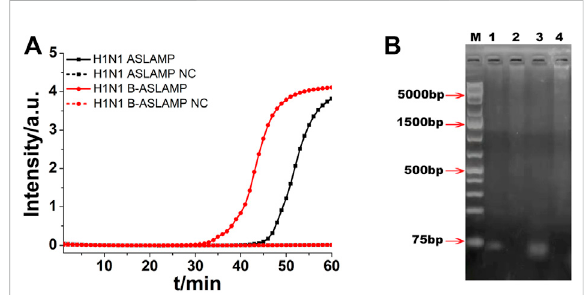
FIGURE 3 (A) ASLAMPand B-ASLAMP ampli fi cations monitored byreal- time PCR carried out at 63 ° C for 60 min. (B) Gel electrophoresis results for ASLAMP and B-ASLAMP products prior and after restriction enzyme digestion. Line M, molecular weight marker. Lane 1, H1N1 ASLAMP product that has been digested by EcoRV . Lane 2, ASLAMP products prior to digestion. Lane 3, B-ASLAMP product that has been digested by EcoRV . Lane 4, B-ASLAMP products prior to digestion. NC is the abbreviation of negative